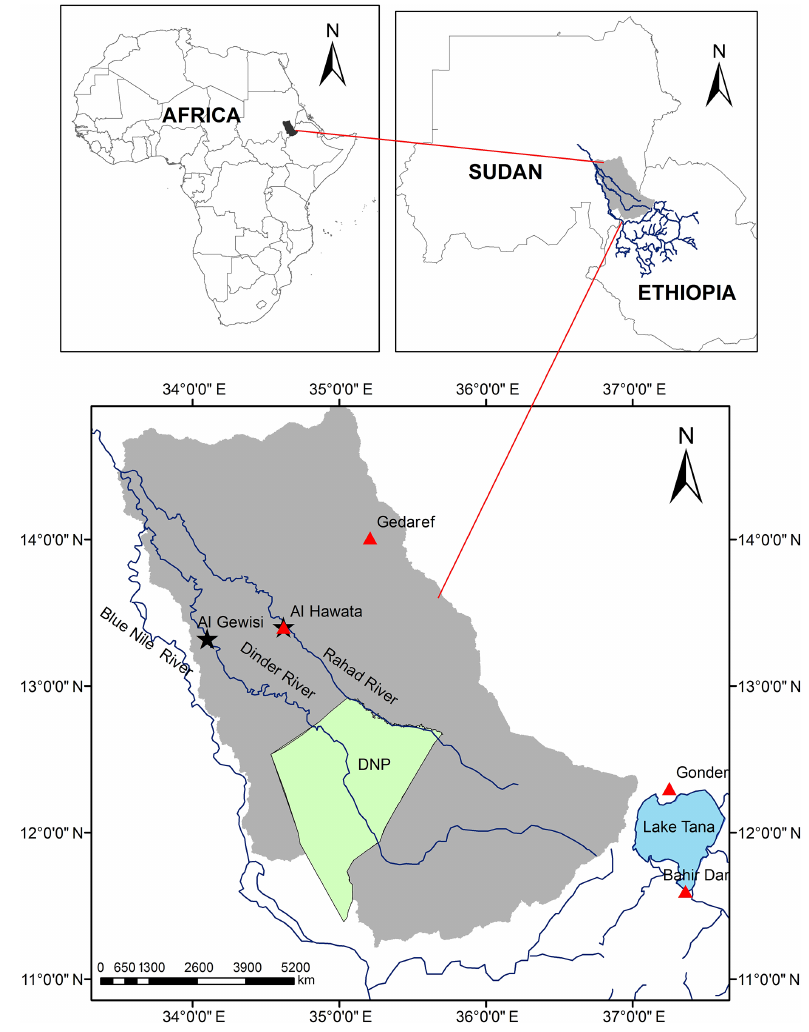
Figure 1. Location map of the Dinder and Rahad basins and the DNP. The two black stars show the locations of the hydrological stations (Al Gewisi and Al Hawata), and the red triangles show the locations of the rain gauges.